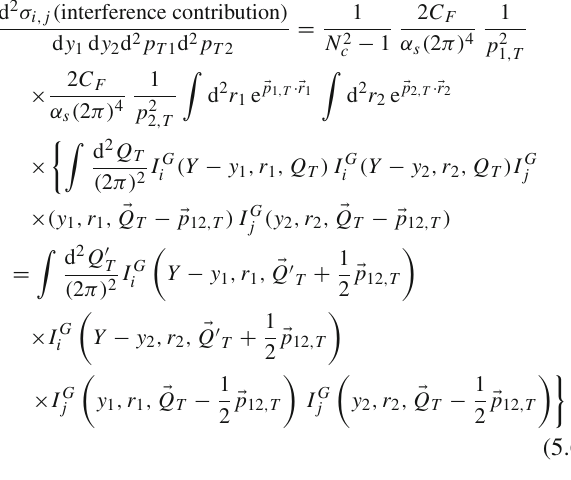
(cid:6) Q T − (cid:6) p 12 , T ,